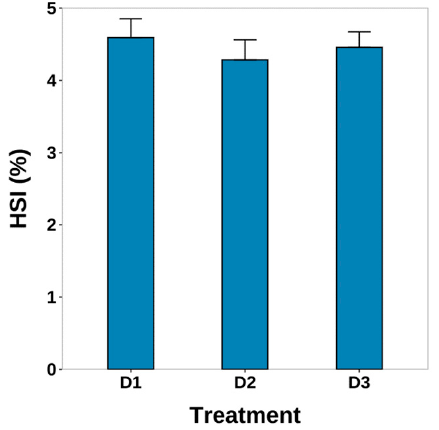
Figure 3. HSI (%) of ovigerous P. clarkii in the three different treatments after 25 days.